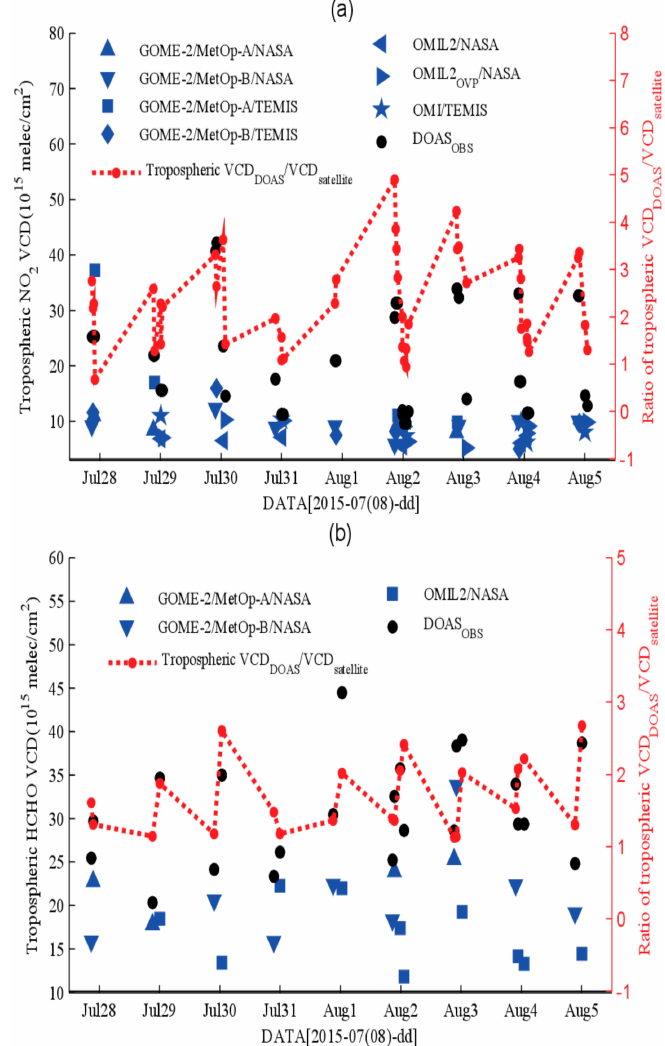
Figure 10. Comparison of concentrations of ( a ) NO 2 and ( b ) HCHO tropospheric vertical column densities retrieved by MAX-DOAS technique with satellite products. The black dots represent the tropospheric NO 2 and HCHO VCDs retrieved by DOAS, the blue dots represent the tropospheric NO 2 and HCHO VCDs from the satellite products, and the red dots represent the ratio of the tropospheric VCDs retrieved by DOAS to the tropospheric VCDs from the satellite